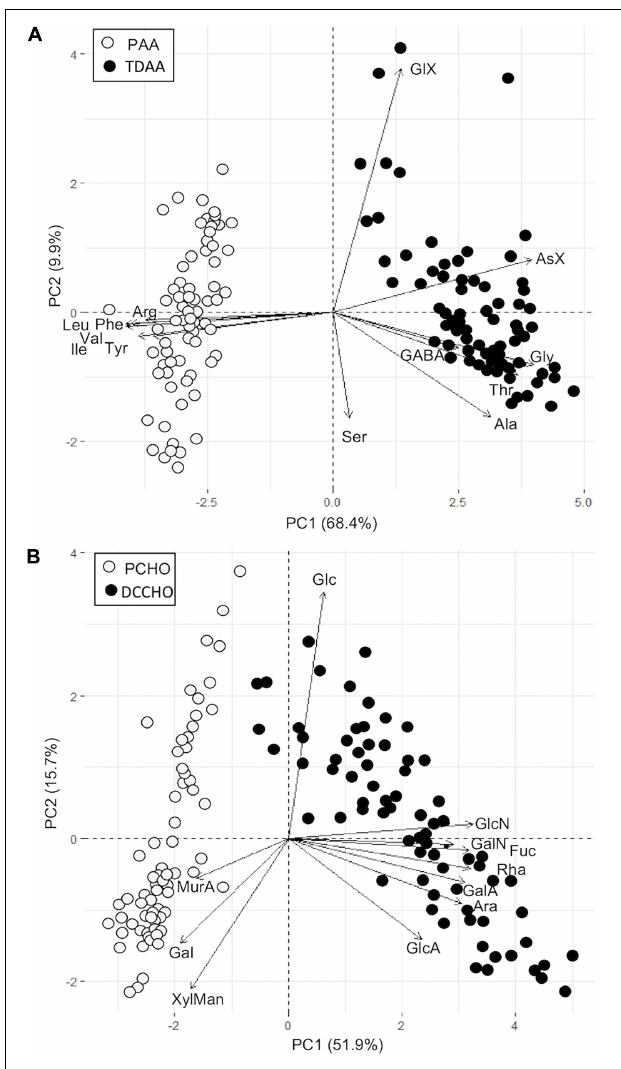
FIGURE 4 | PCA biplot of distribution AA (A) and CHO (B) in dissolved and particulate